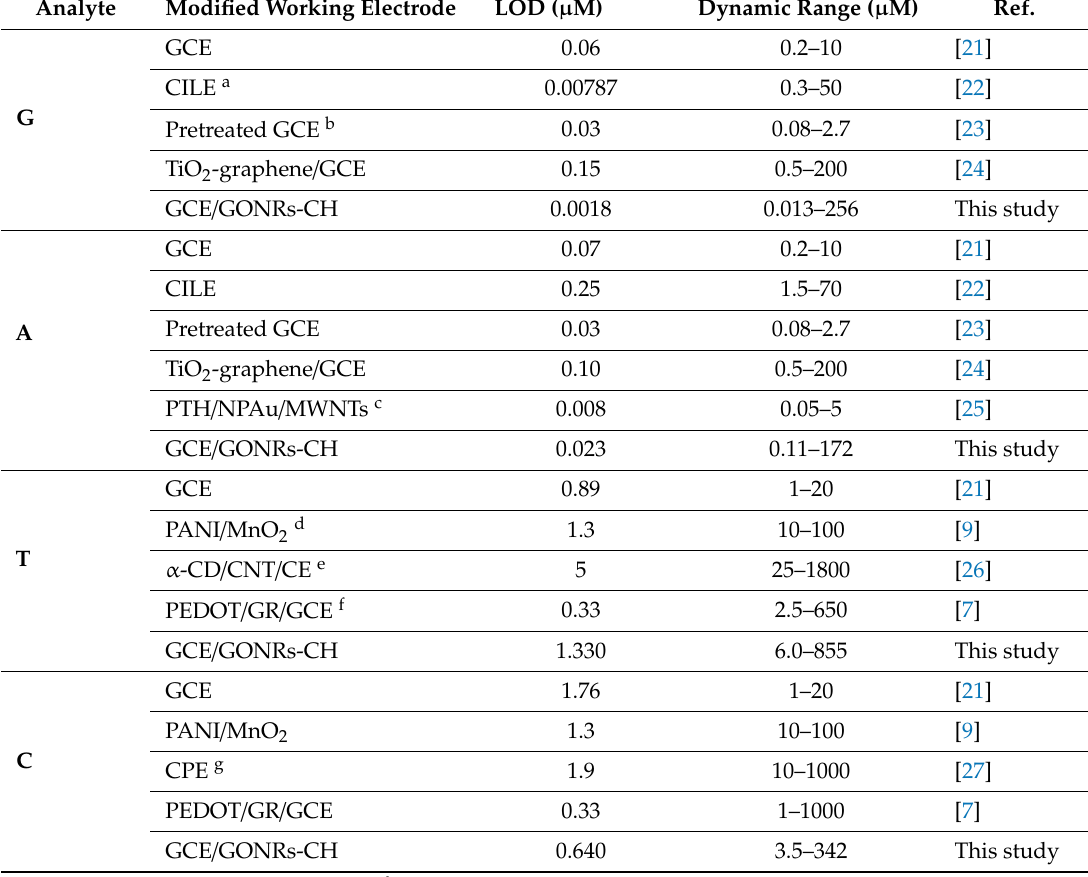
Table 2. Analytical performance of GCE / GONRs-CH in comparison with those reported in the literature.